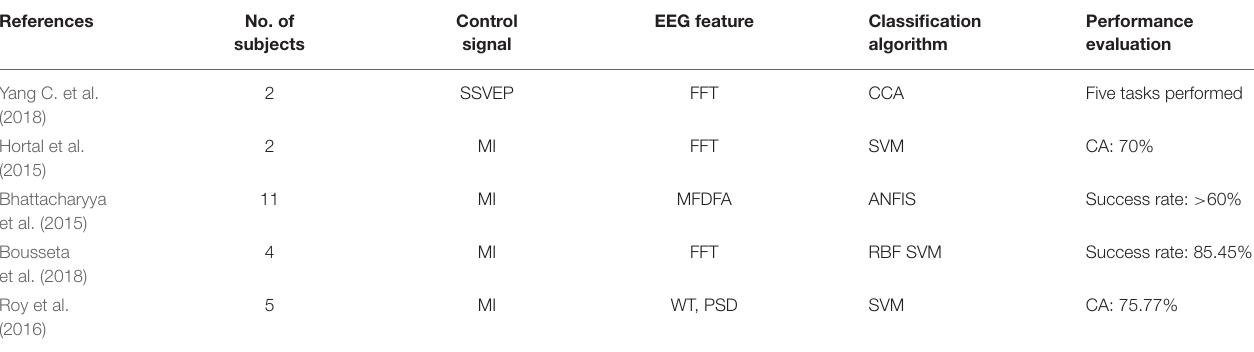
TABLE 9 | Summary of EEG-based BCI robotic arm